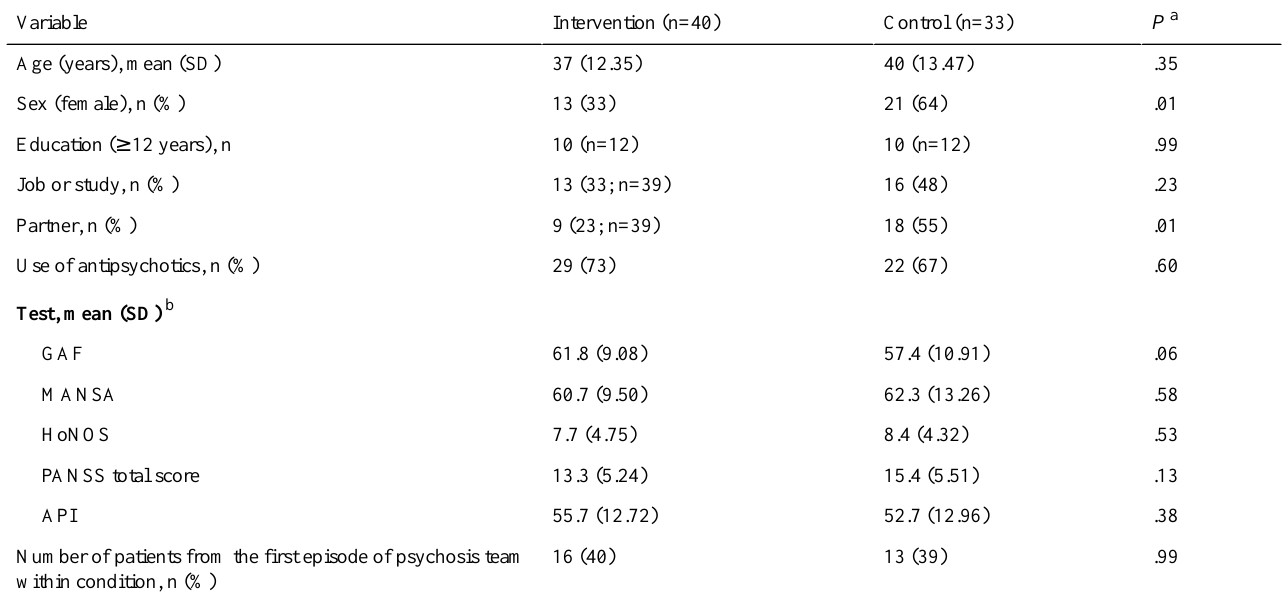
Table 2. Demographic variables and baseline data of study participants.